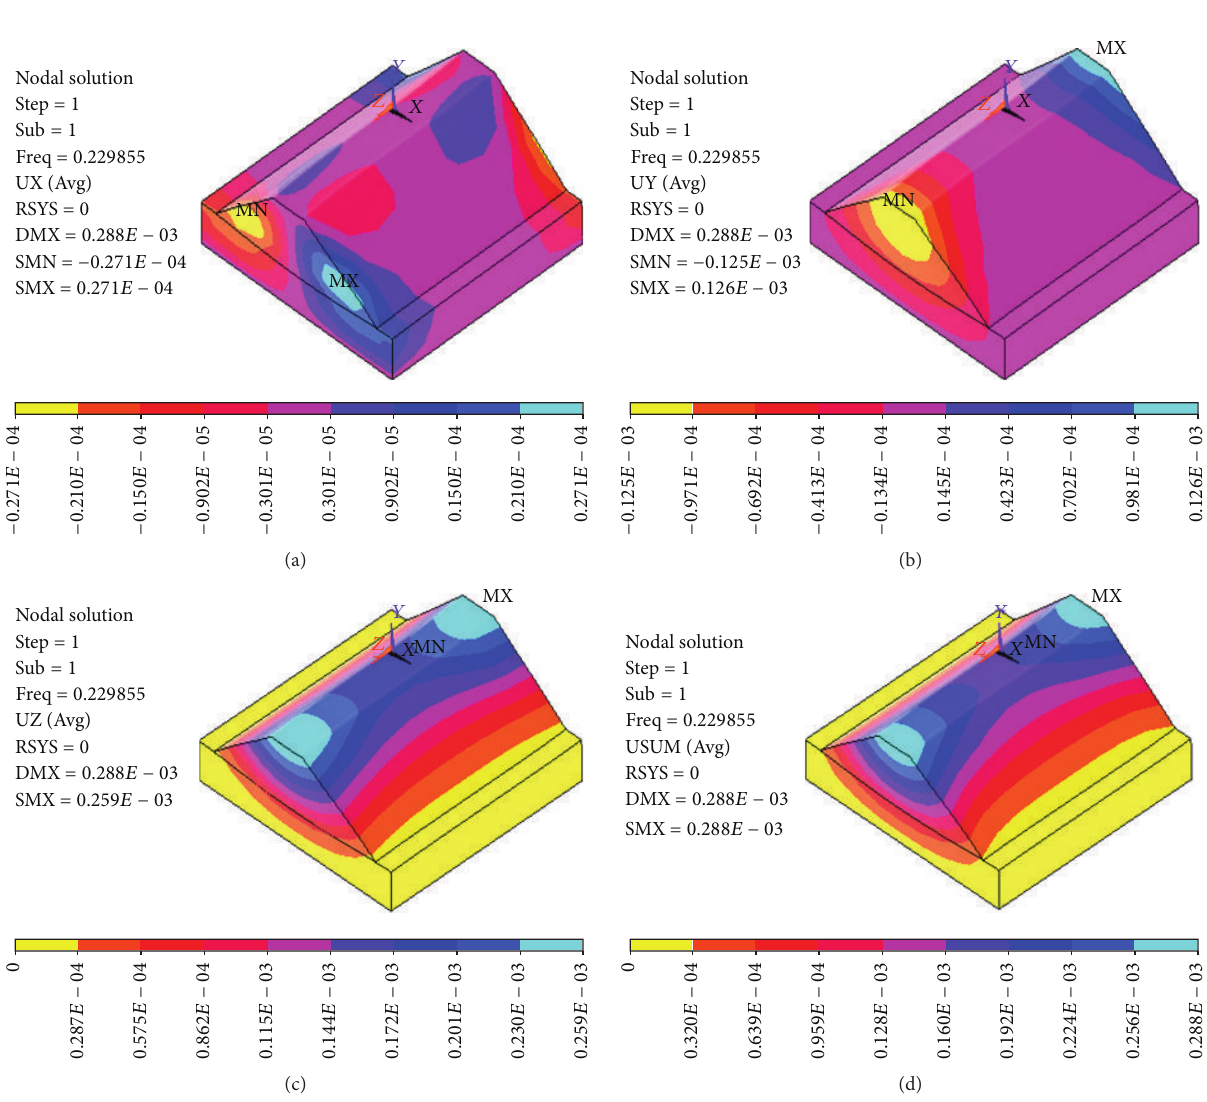
Figure 16: Mode shape 1. (a) horizontal displacement, (b) vertical displacement, (c) lateral displacement, and (d) total